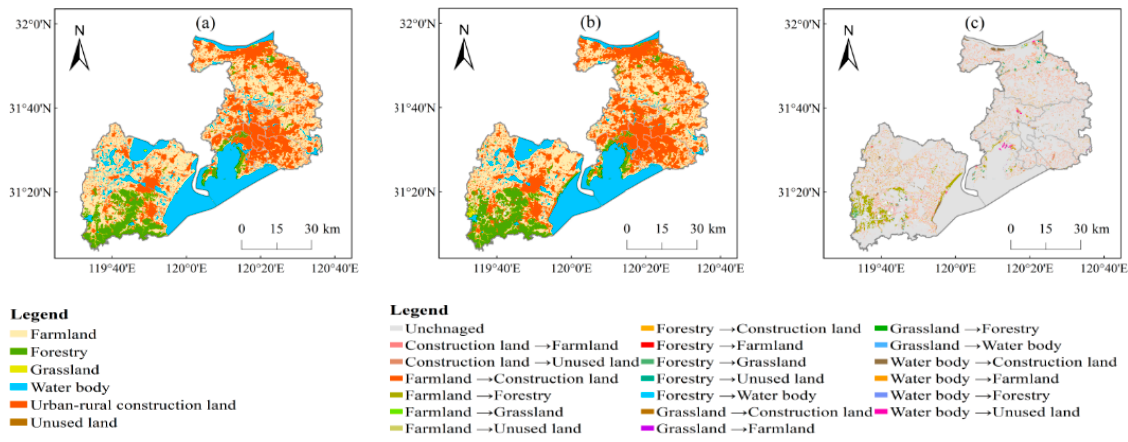
Figure 9. Forecast map of land use changes in Wuxi area: 2020 (( a ), Simulation), 2030 ( b ), 2020–2030 ( c ).